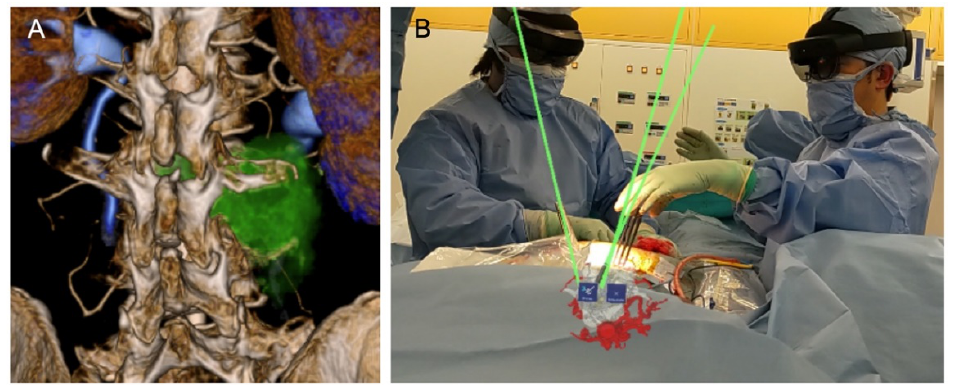
Figure 2. Three-dimensional medical images and holograms for preoperative simulation ( A ) and intraoperative surgical assistant ( B ). The green line was used as a guideline for the insertion of pedicle screws.